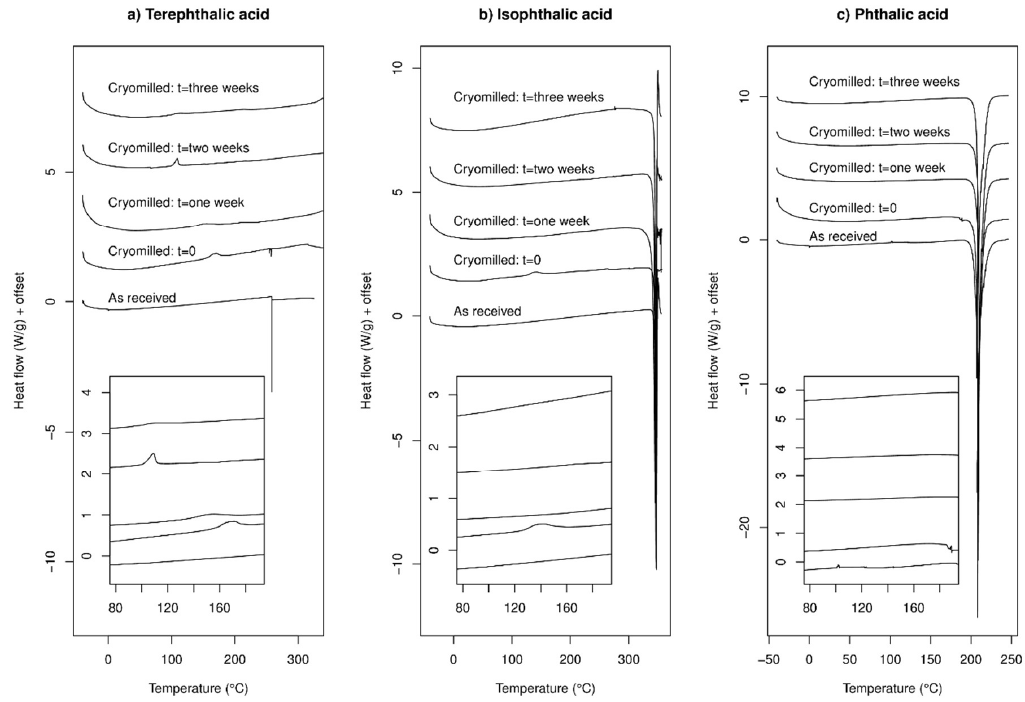
Figure 2. Di ff erential Scanning Calorimetry (DSC) data for: ( a ) TPA; ( b ) IPA; and ( c ) PA. Exothermic Figure 2. Differential Scanning Calorimetry (DSC) data for: a ) TPA; b ) IPA; and c ) PA. Exothermic up.